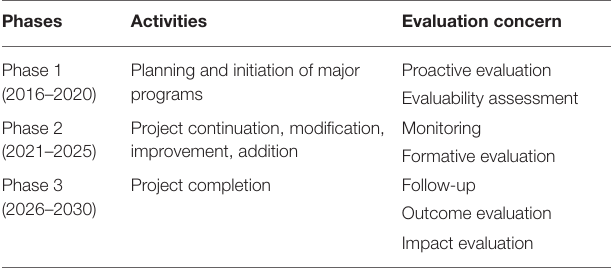
TABLE 1 | Three 5-years phases for SDG implementation and evaluation, according to Yonehara et al. (2017).